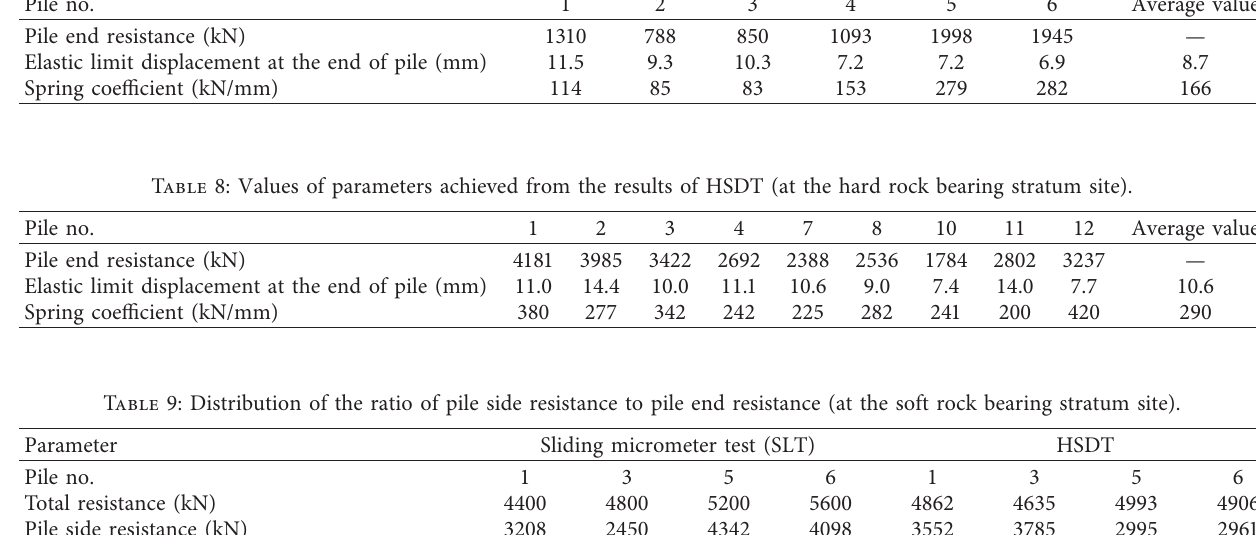
Table 7: Values of parameter obtained from results of HSDT (at the soft rock bearing stratum site). Pile no.